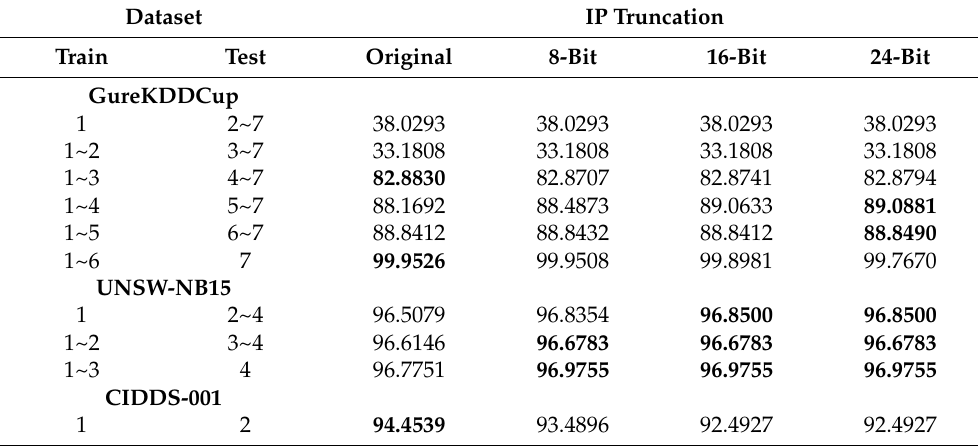
Table 3. Classification Accuracy (%) for each C4.5 Tree Model in Full GureKDDCup’99, UNSW-NB15, and